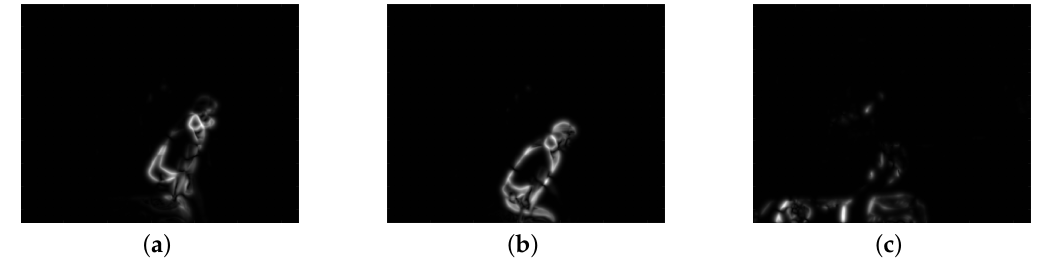
Figure 6. Examples of image features from cameras inside a